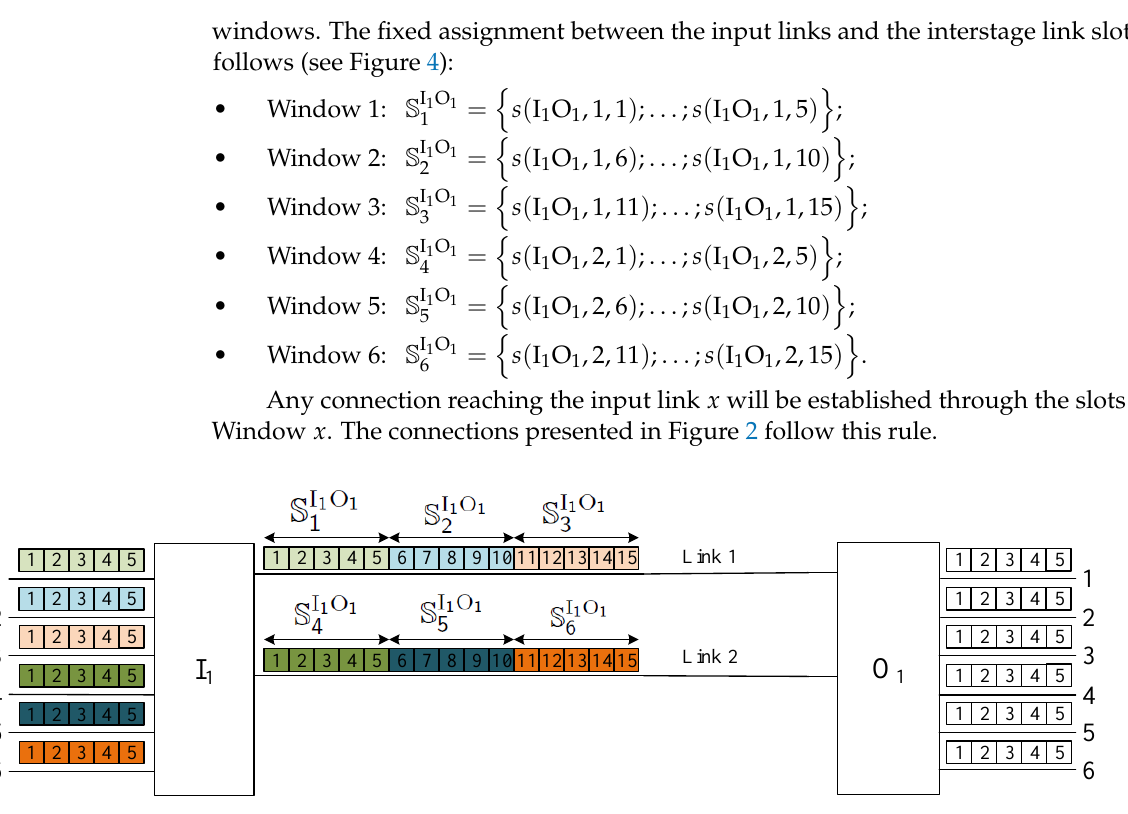
Figure 4. Division of slots in two interstage links between switches I 1 and O 1 into sets in case of the switching network presented in Figure 2.